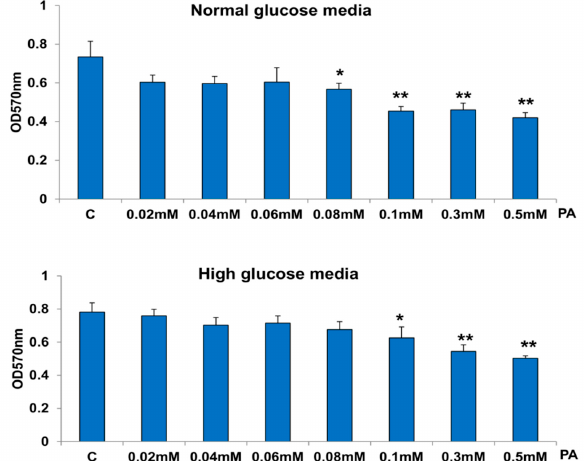
Figure 1. Effect of high glucose/high palmitic acid (HG/HPA) on cell viability. HepG2 cells (~2 × 10 4 ) were treated with MTT as described in the Materials and Methods section, and viability was measured by formazan formation as a mitochondrial function of viable cells and measured at 570 nm. ‘C’ represents untreated control cells. The results are expressed as mean +/ − SEM of three independent experiments. The asterisks indicate significant difference (* p ≤ 0.05, ** p ≤ 0.005,) from the control untreated cells. A significant increase (31%) in ROS production was seen with 0.3 mM PA in the presence of NG, while 0.06 mM PA showed no appreciable effects. On the other hand, PA treatment markedly increased (60–70%) ROS production in the presence of HG (Figure 2A). These results suggest that PA treatment augments ROS production in the presence of high glucose. FACS and microscopic